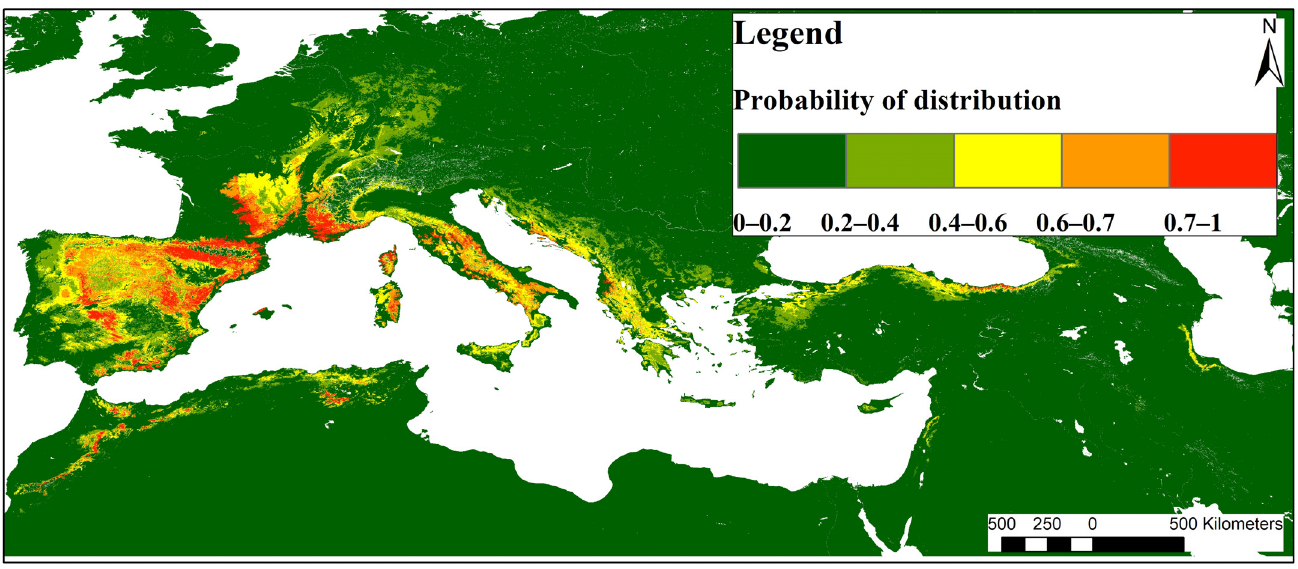
Figure 7. The current predicted distribution of the Montpellier Maple by class of suitability.